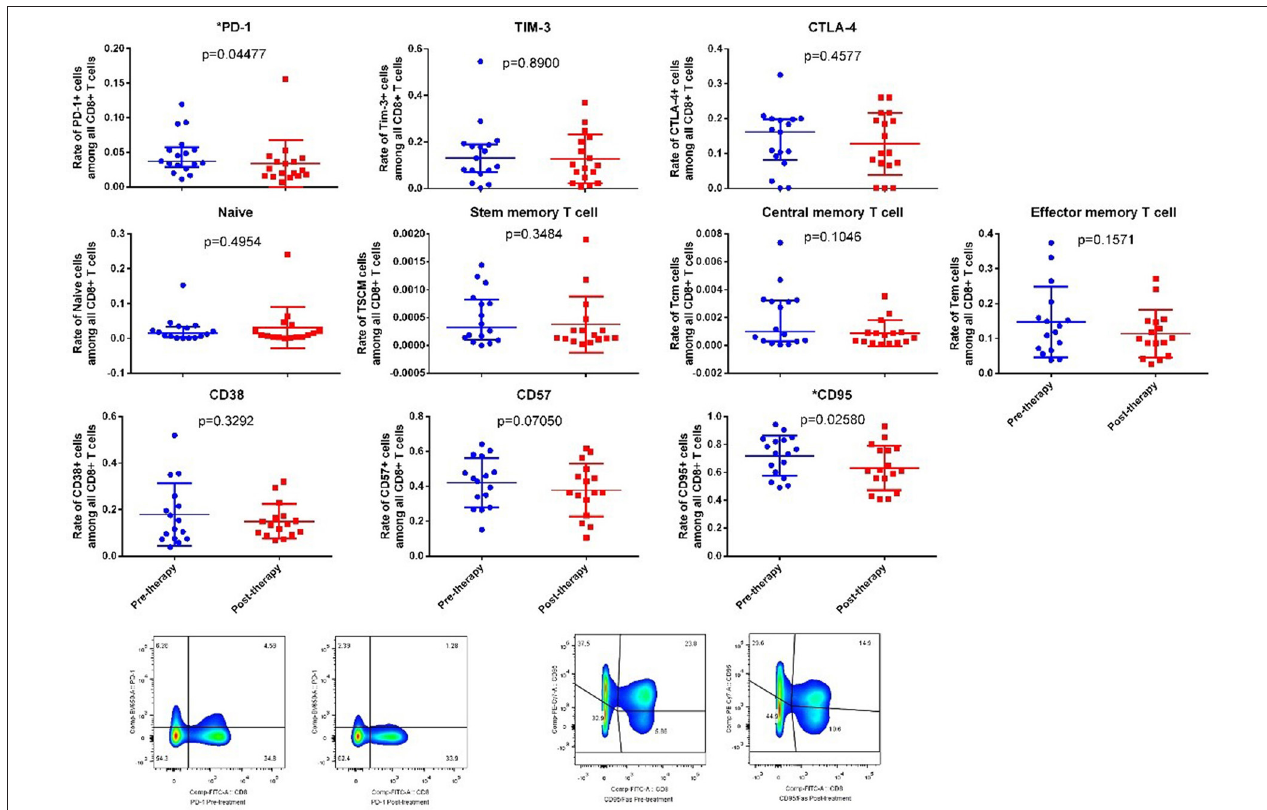
FIGURE 3 | The changes of all the marker’s expressions of laboratory evaluations of efficacy. Legend: Each dot represents an individual data, the horizontal line on each set of data represents the mean ± standard deviation (normal distribution data), or median, 25% quartile and 75% quartile (skewed distribution data).